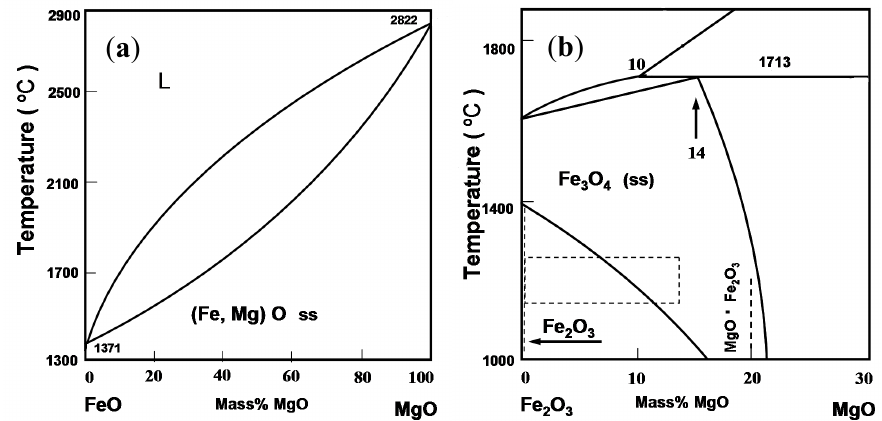
Figure 10. Phase diagram of FeO x –MgO ( a ) FeO–MgO; ( b ) Fe 2 O 3 –MgO.